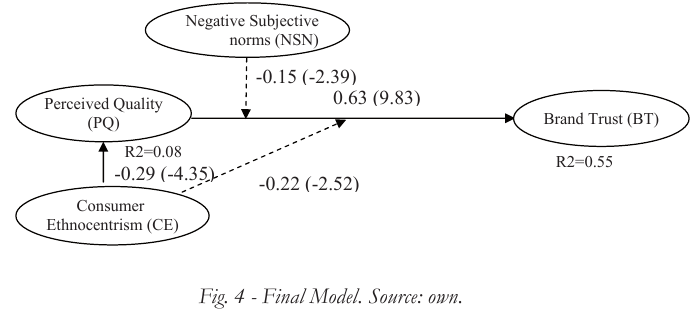
Fig. 4 - Final Model. Source: